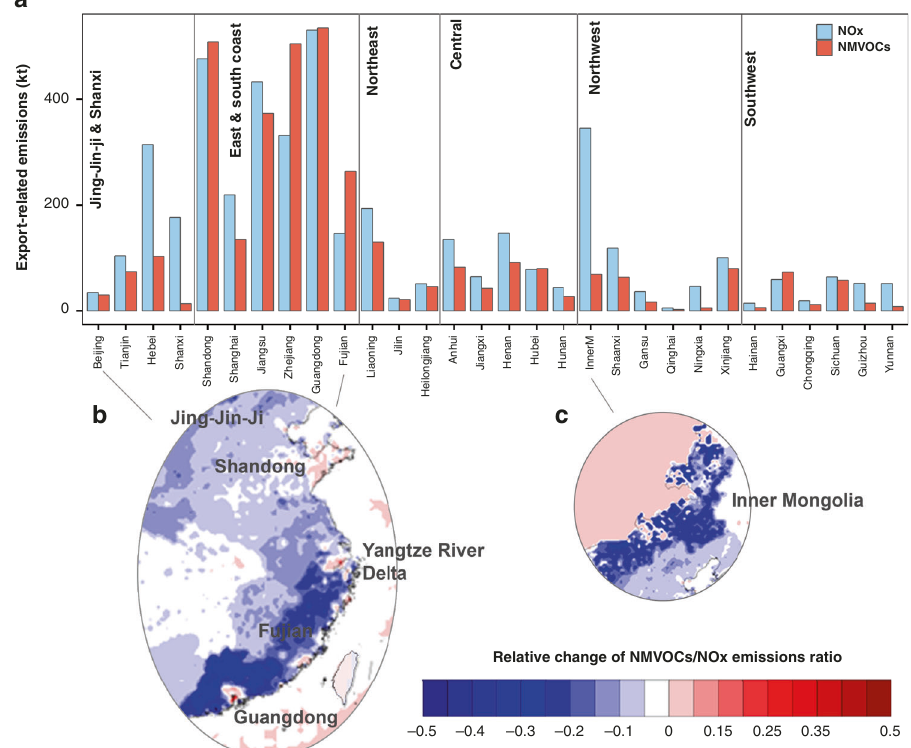
Fig. 2 Relative emissions of NMVOCs and NOx alerted by export demand. a Absolute value of NOx (in blue) and NMVOCs (in red) related to export demand by provinces. b Relative change in the ratio between anthropogenic NMVOCs to NOx emissions in the east and south coast in July. Blue indicates that export demand decreases the NMVOC/NOx ratio and red for increase. Export generally increased the NMVOC/NOx ratio in urban areas or industrial sites, but decreased the ratio in rural areas. c Export signi fi cantly decreased the NMVOC/NOx ratio in the Inner Mongolia since export demand in this province was largely associated with activities from power supply sectors to support the production of export goods with intensive NOx emissions. The relative changes in other provinces are generally less than 10% and not shown here. Source data are provided as a Source Data fi